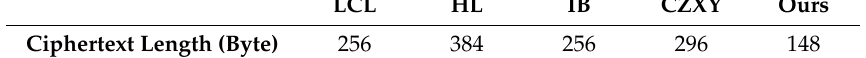
Table 3. Comparisons of communication overheads in three-party communication environments.